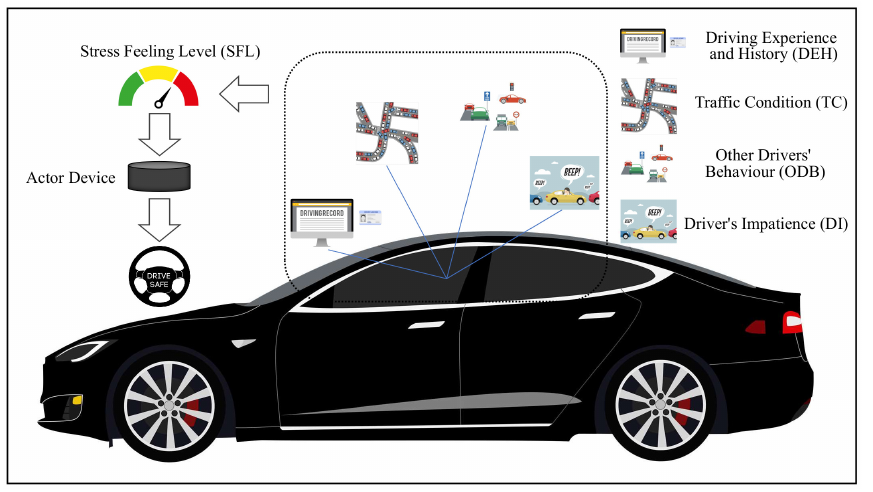
Figure 1. Concept of